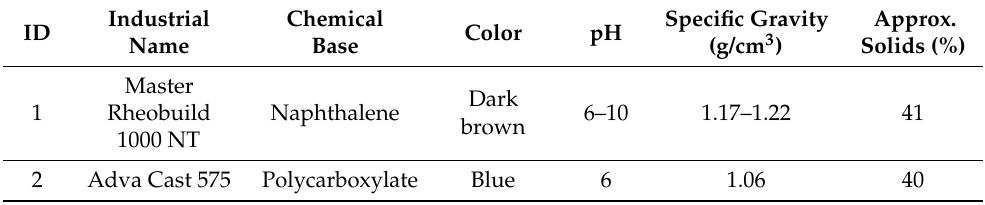
Table 3. Physical and chemical characteristics of